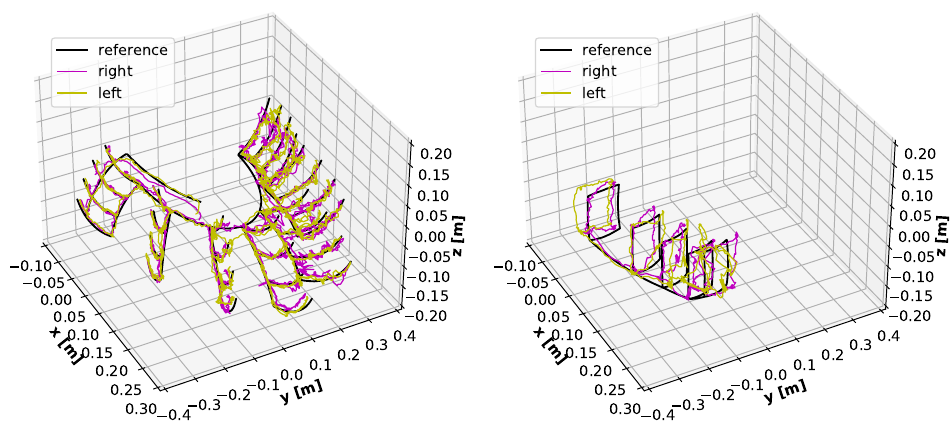
Figure 15. Trajectories in Cartesian space for the sparse CNN model. Black: set trajectory; colours: predictions from the left (yellow) and the right (magenta) camera.